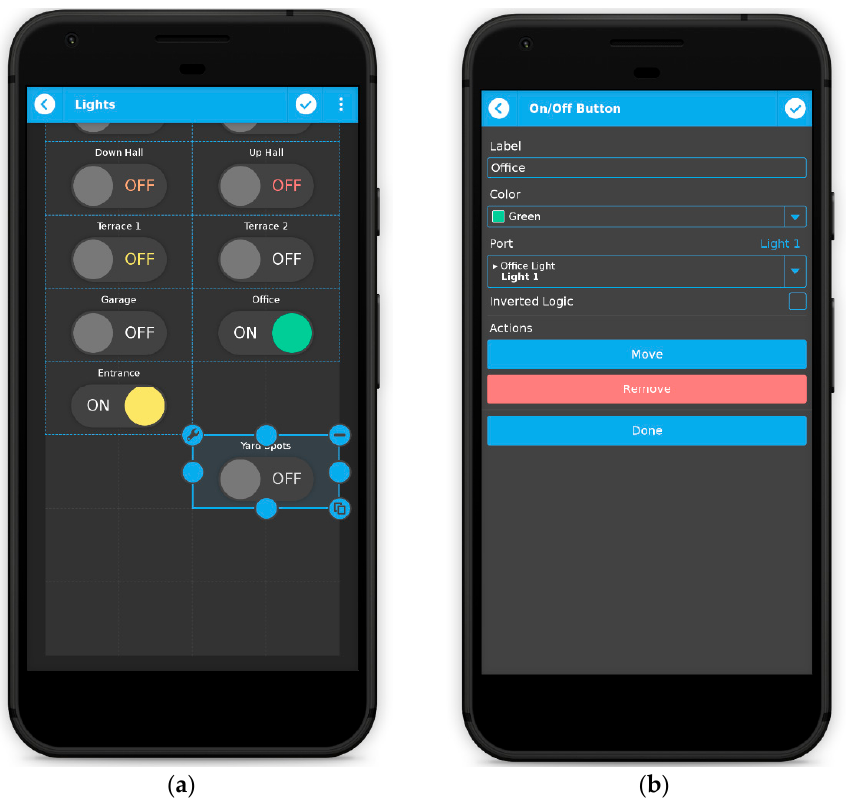
Figure 5. Working with widgets: dashboard layout ( a ), widget properties ( b ).